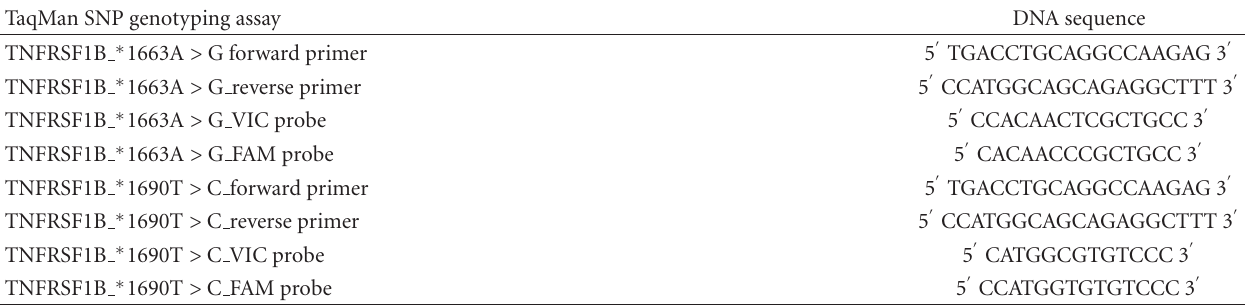
Table 3: Primer and probe sequences for custom-made TaqMan SNP genotyping assay for TNFRSF1B. TaqMan SNP genotyping assay DNA